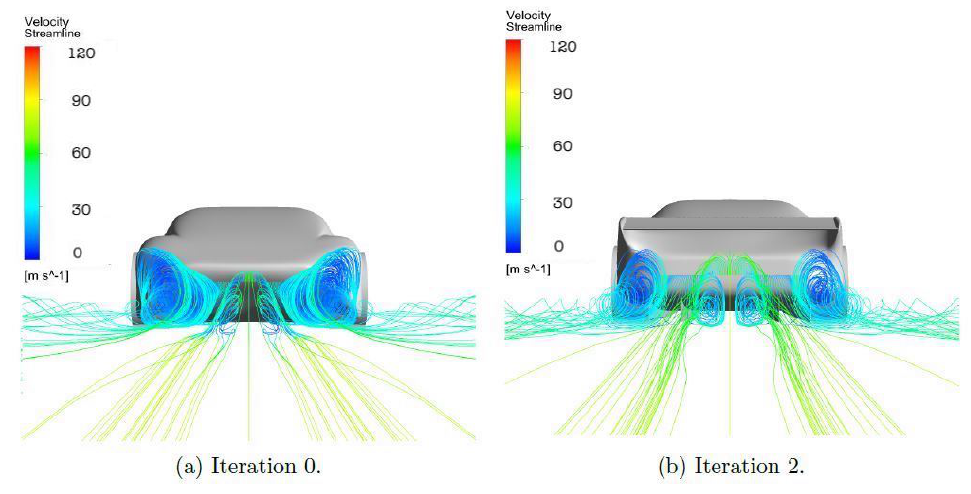
Figure 7. Wake vorticity comparison after using the adjoint solver